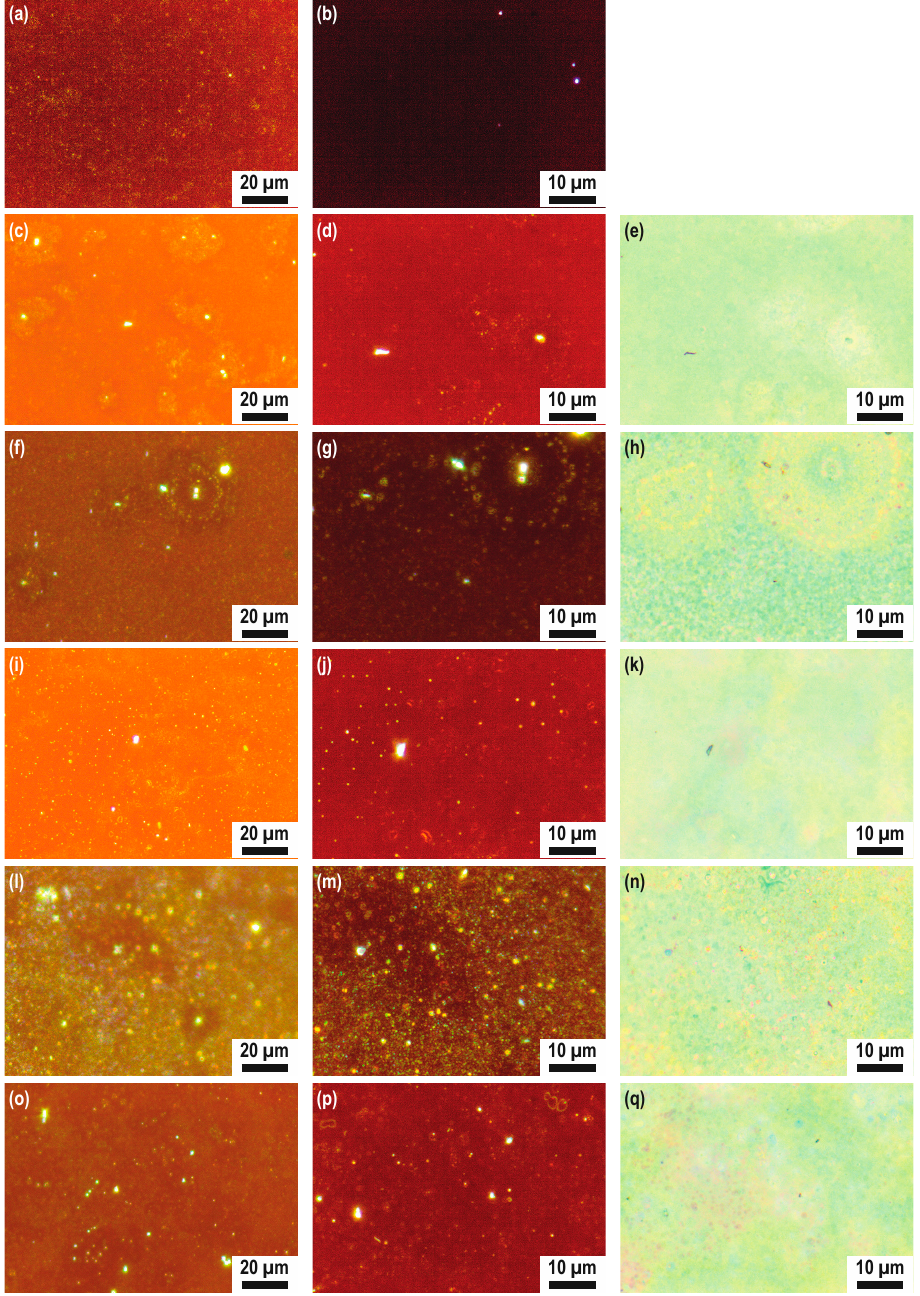
Figure A3. BPFMO film surfaces as observed by optical microscopy with X50 (left) and X100 (middle and right) objectives, both in dark field (left and middle) and in bright field (right), with evidence of inhomogeneities at micrometric scale, for the different Pr substitution concentrations in line: ( a ),( b ) 5%, ( c ) – ( e ) 10%, ( f ) – ( h ) 12.5%, ( i ) – ( k ) 15%, ( l ) – ( n ) 17.5%, and ( o ) – ( q ) 20%.